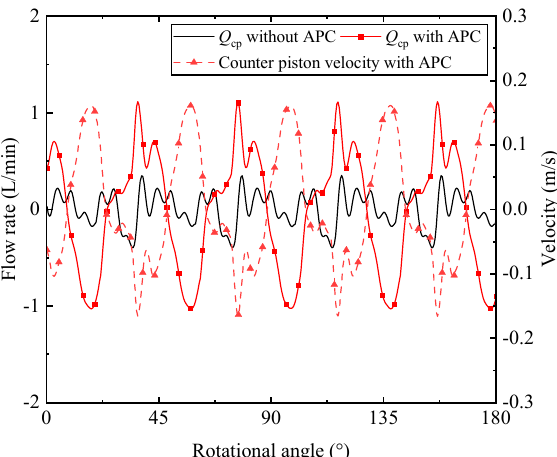
Figure 10. The effect on the flow from counter piston chamber and counter piston velocity.